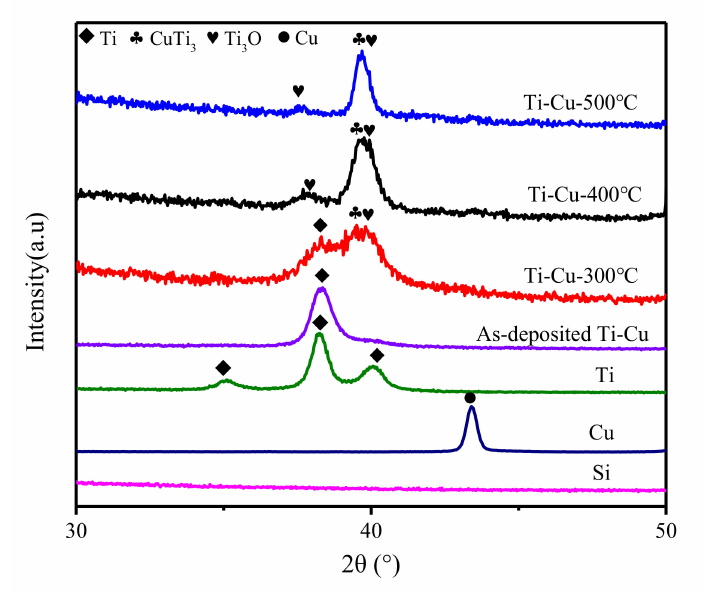
Figure 2. X-ray di ff raction (XRD) patterns of Ti, Cu, and Ti–Cu coatings deposited on silicon substrates before and after annealing at temperatures of 300 ◦ C, 400 ◦ C, and 500 ◦ C.